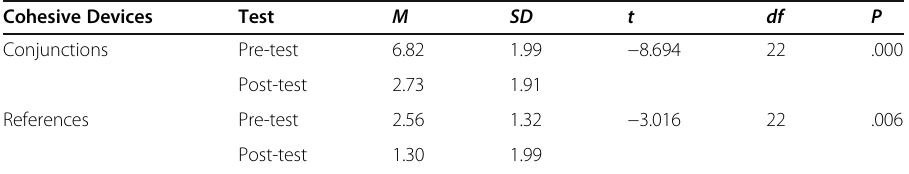
Table 7 Mean errors, standard deviation and paired sample t-test results of conjunctions and references in cloze-tests